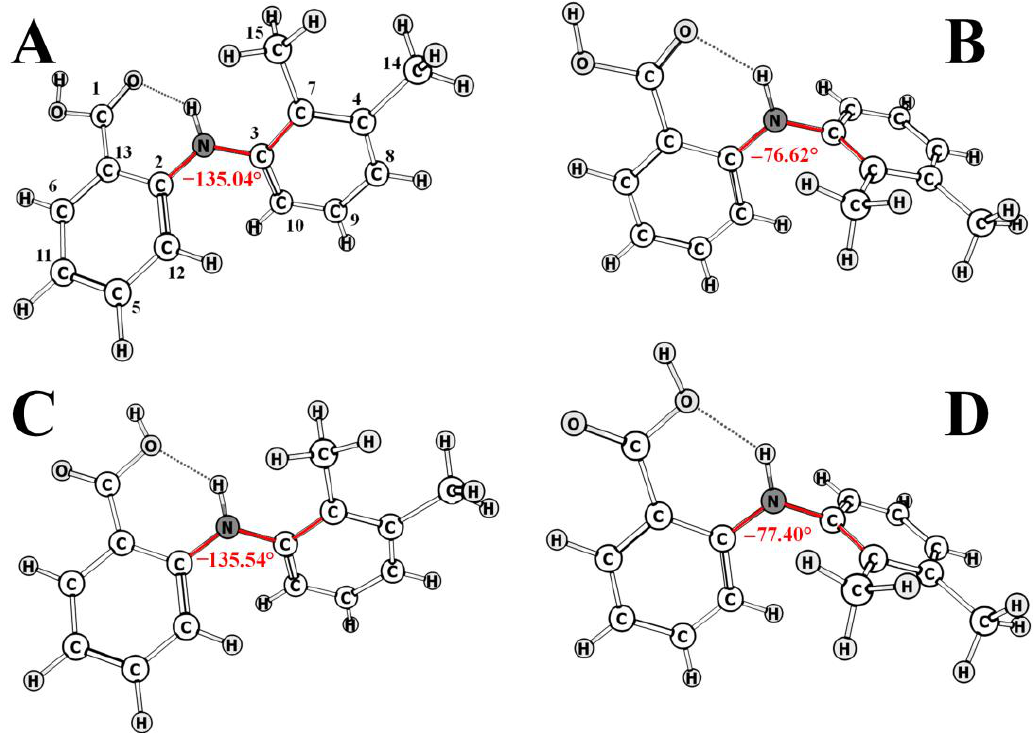
Figure 6. Conformers of the MFA molecule ( A – D ) are indicated by the number of carbon atoms and their associated hydrogen atoms; the numbering of atoms remains the same for the remaining conformers. The red color indicates the C2-N(H)-C3-C7 dihedral angle, and its value results vary in different conformations of MFA.